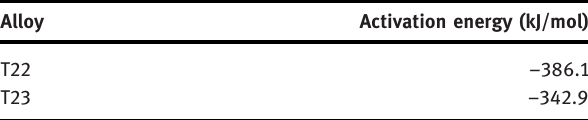
Table 3: Activation energies (kJ/mol) for T22 and T23 alloys exposed at 657°C and 725°C for 500